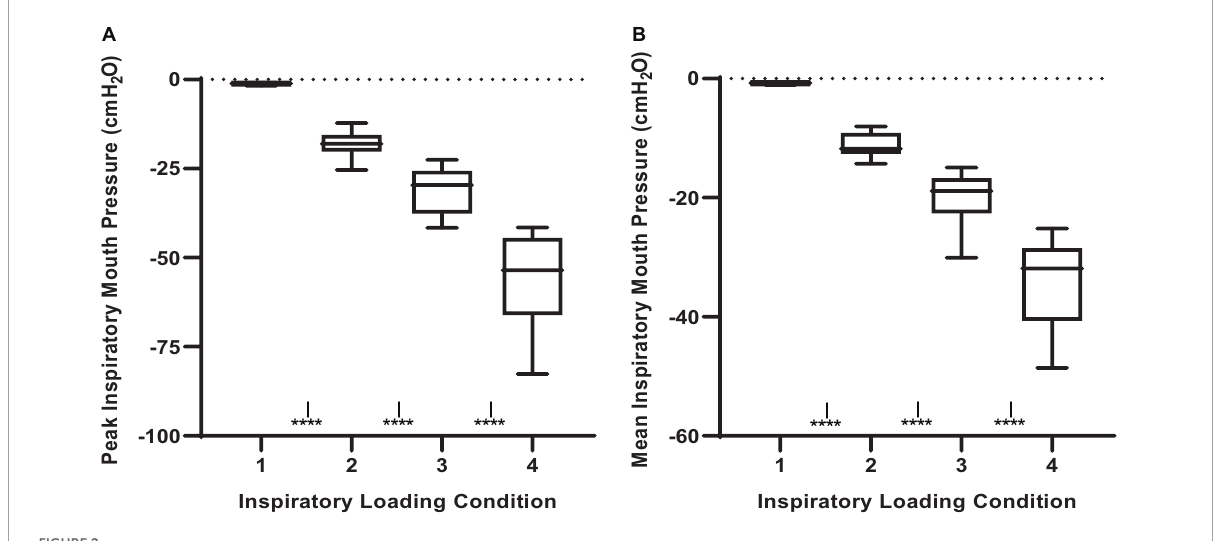
FIGURE2 Peak and mean inspiratory mouth pressure swings across inspiratory threshold loading conditions during masked conjunctive continuous performance trials. (A) Depicts the differences in peak inspiratory mouth pressure across loading conditions. (B) Depicts the differences in mean inspiratory mouth pressure across loading conditions. The upper and lower limits of the box represent the 95% CI, the horizontal line in the box represents the mean, and the whiskers represent the SEM. ****Significant difference from previous load condition, P < 0.0001, I Significant difference from load condition 1, P <